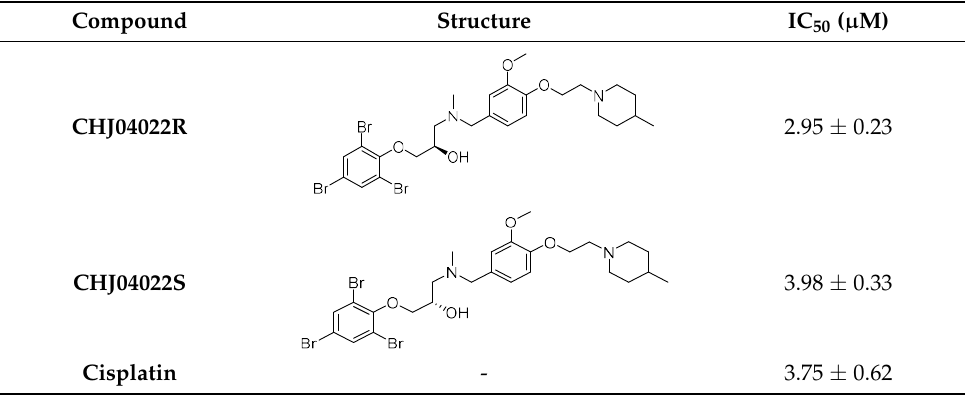
Table 4. In vitro inhibitory activity of CHJ04022R and CHJ04022S against A375. Compound